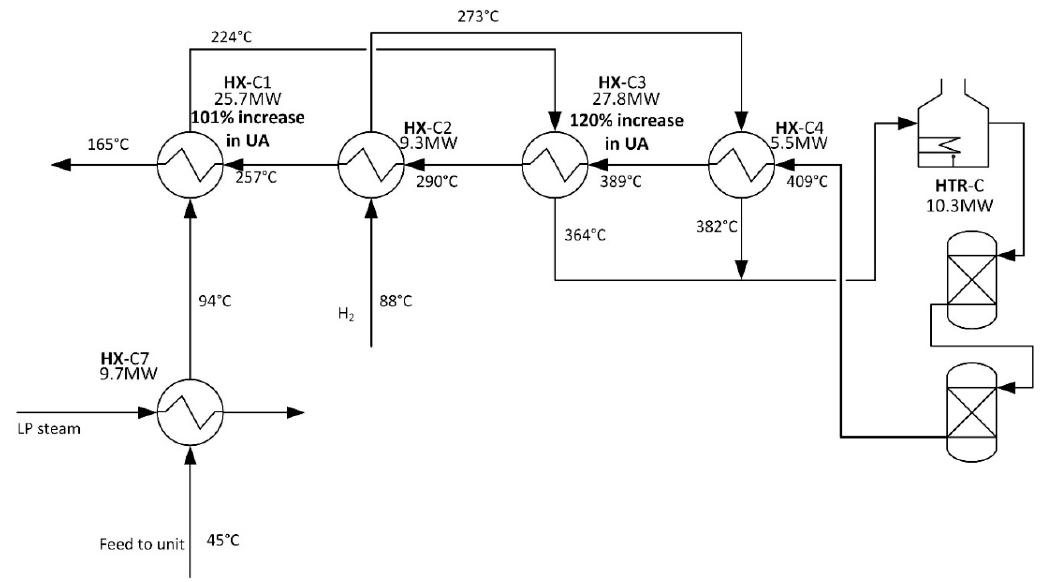
Figure A8. Retrofit proposal 4B.